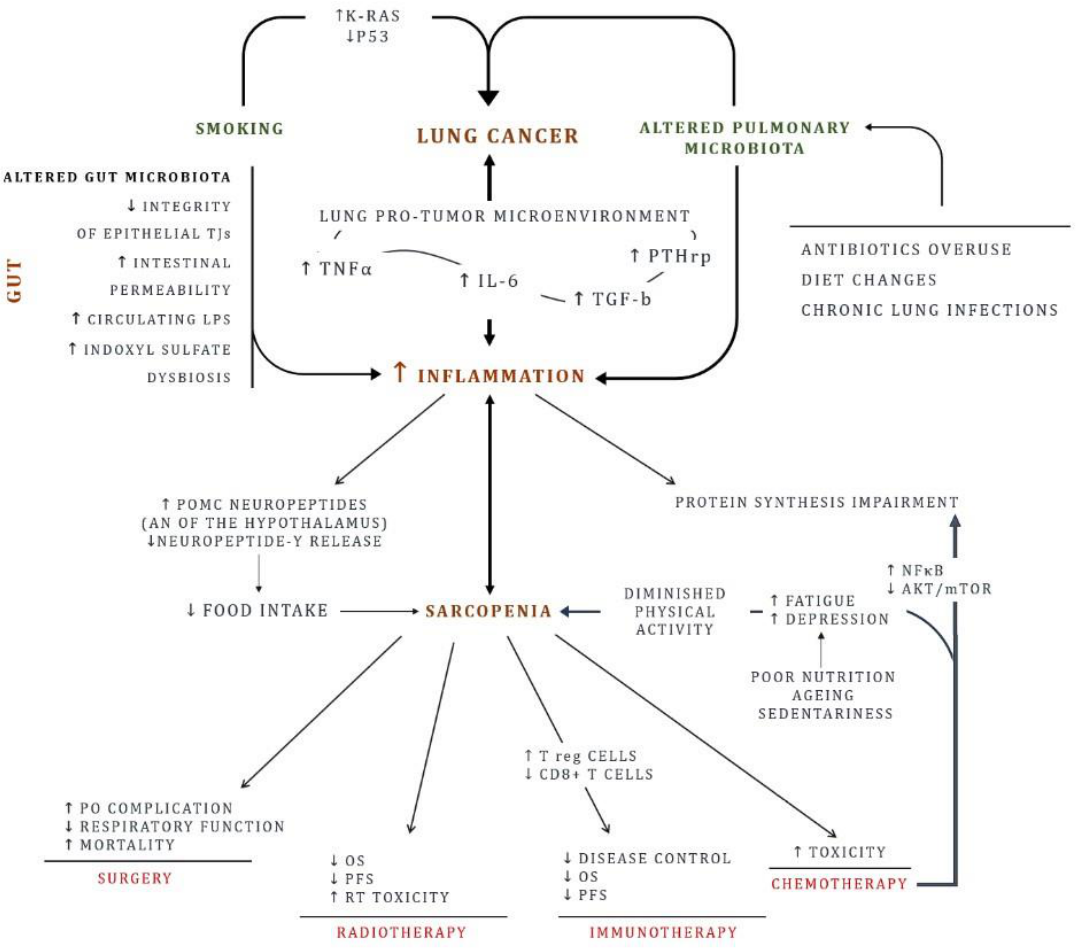
Figure 1. Lung cancer risk factors: focus on inflammation chronic inflammation, and sarcopenia. In addition to smoking, lifestyle (diet change, physical activity, pulmonary and gut microbiota) represents a risk factor postulated to contribute to lung cancer origin. The resulting inflammation ignites the carcinogenesis. On the other hand, inflammation is sustained in the tumor microenvironment, closing the vicious circle. Likewise, gut plays a key role. An impaired intestinal mucosa and an altered gut microbiota promotes inflammation. With time, skeletal muscle weakens. Physical inactivity combined with inadequate diet exacerbates the scenario and sarcopenia development. AKT: Protein kinase B; AN: Arcuate nucleus; IL- 6: Interleukin 6; mTOR: mammalian target of rapamycin; NFκB: Nuclear factor kappa -light-chain-enhancer of activated B cells; LPS: Lipopolysaccharides; OS: overall survival; PFS: Progression-free survival; PO: Post-operative; POMC: Pro- opiomelanocortin; PTHrp: Parathyroid hormone-related protein; RT: Radiotherapy; TJs: tight junctions; TGF- β: Trans- forming growth factor beta; TNFα: Tumor necro sis factor alpha.